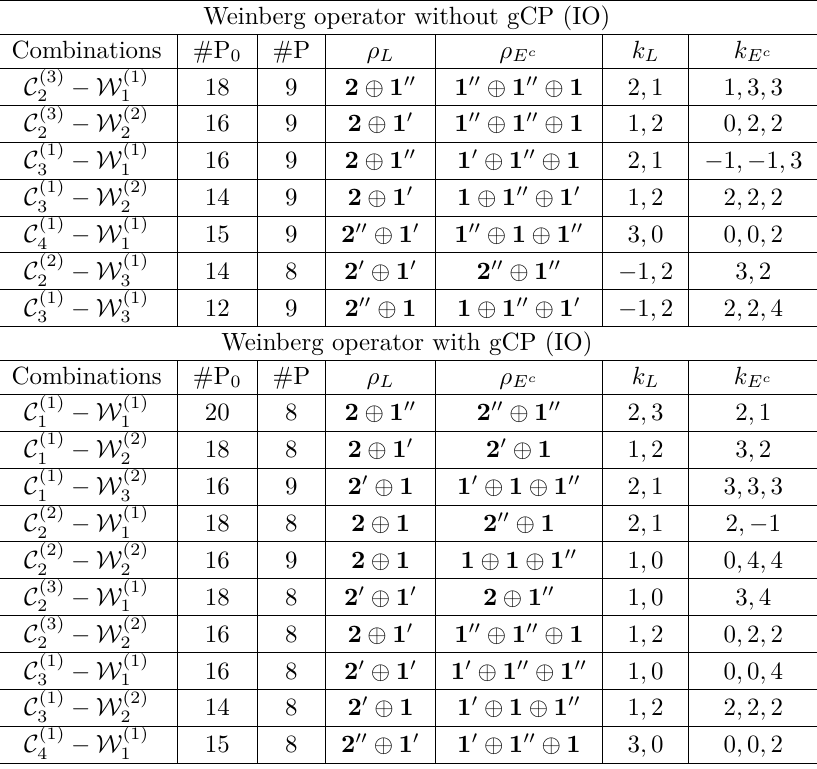
Table 20. The same as in table 18 but for IO neutrino